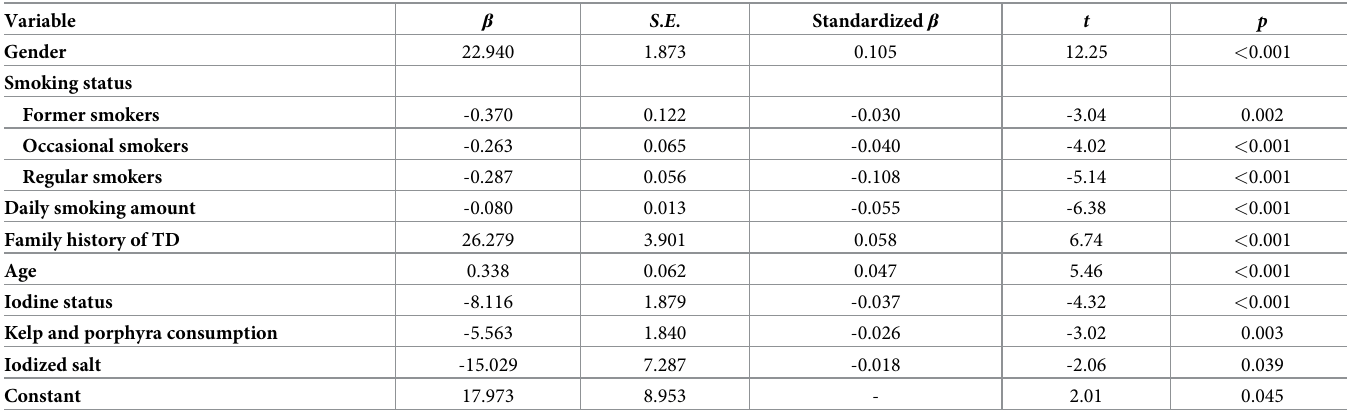
Table 5. Multivariate analysis of factors related to Ln TPOAb. Variable